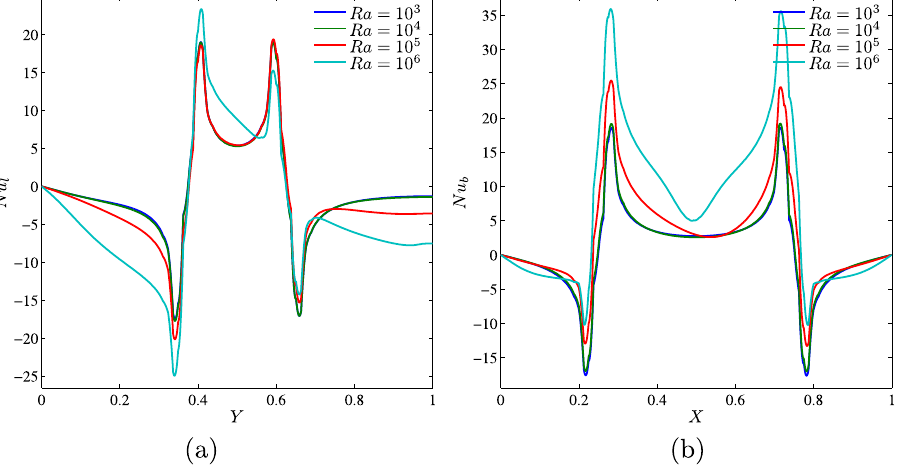
Figure 8. Variation of local Nusselt number interfaces with ( a ) Y and ( b ) X for different Ra at φ = 0.02, Ha = 15, k w = 0.76 and D = 0.3.